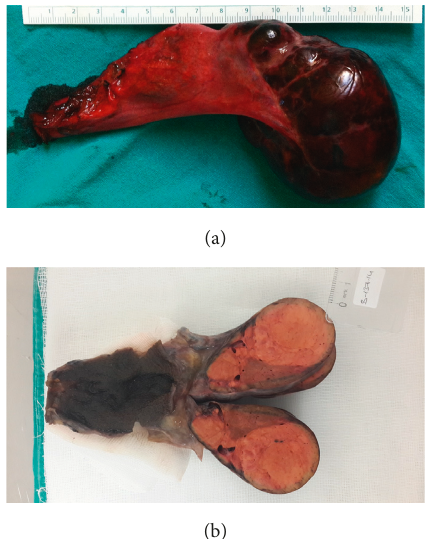
Figure 3: (a) and (b) Macroscopically, 7 × 5.5 × 4 cm ectopic liver adenoma in the gallbladder fundus serosa with no connection to the mother liver.